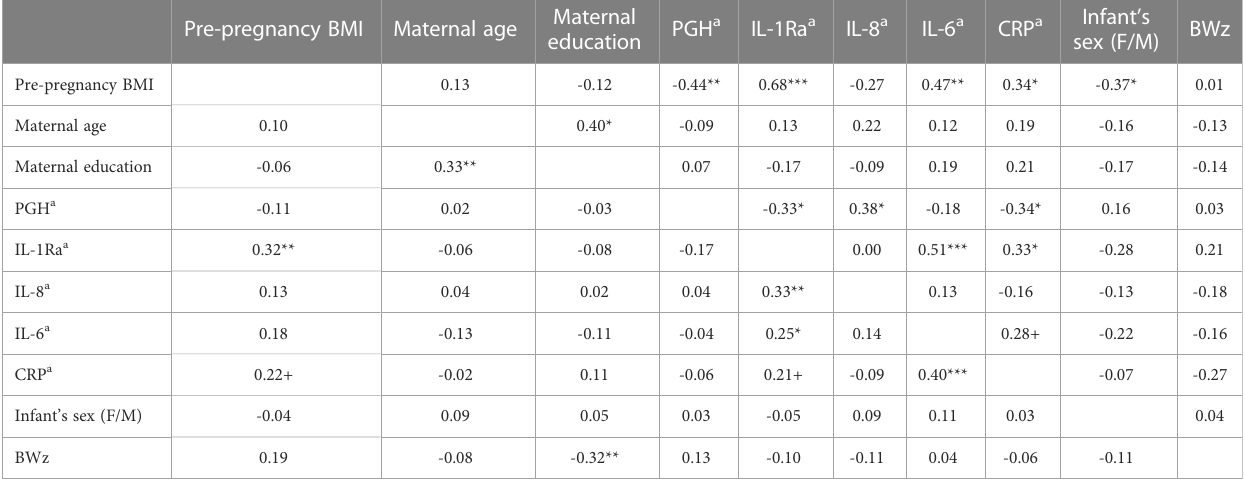
TABLE 3 Bivariate correlations between focal predictors shown separately for Black and White women, above and below the diagonal, respectively.